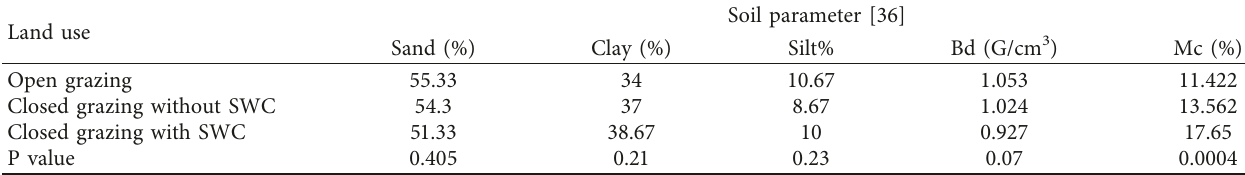
Table 7: Impacts of SWC measures on soil physical properties with different land uses. Land use